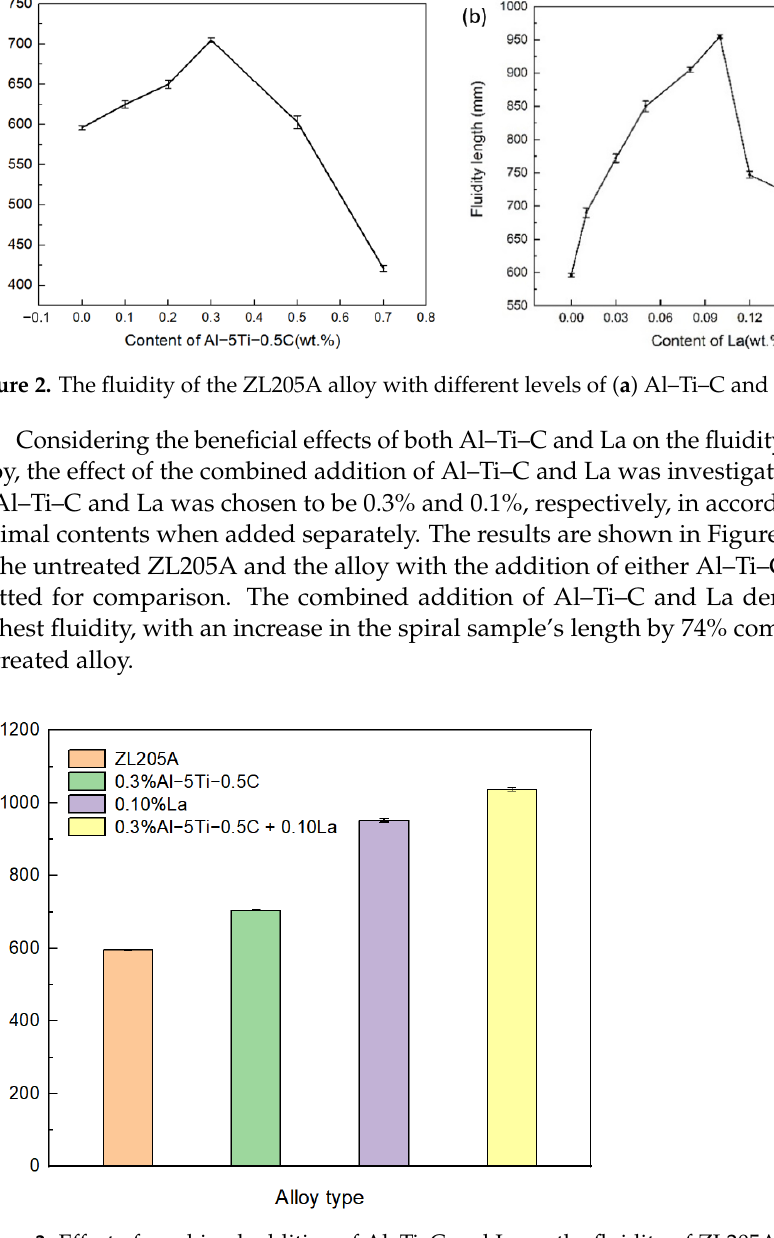
Figure 3. Effect of combined addition of Al−Ti−C and La on the fluidity of ZL205A alloy.